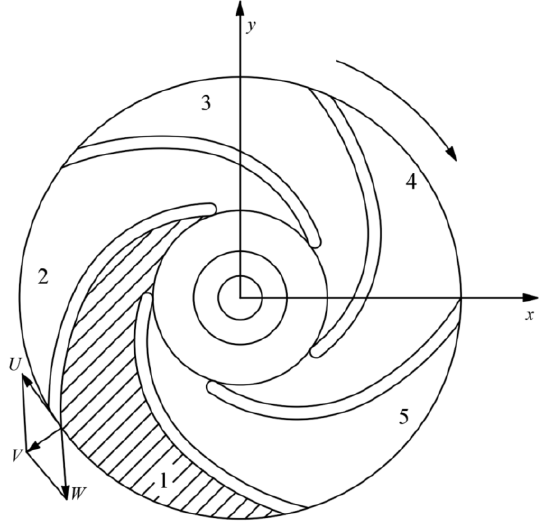
Figure 4. Schematic diagram at mid-span of OTE impeller.